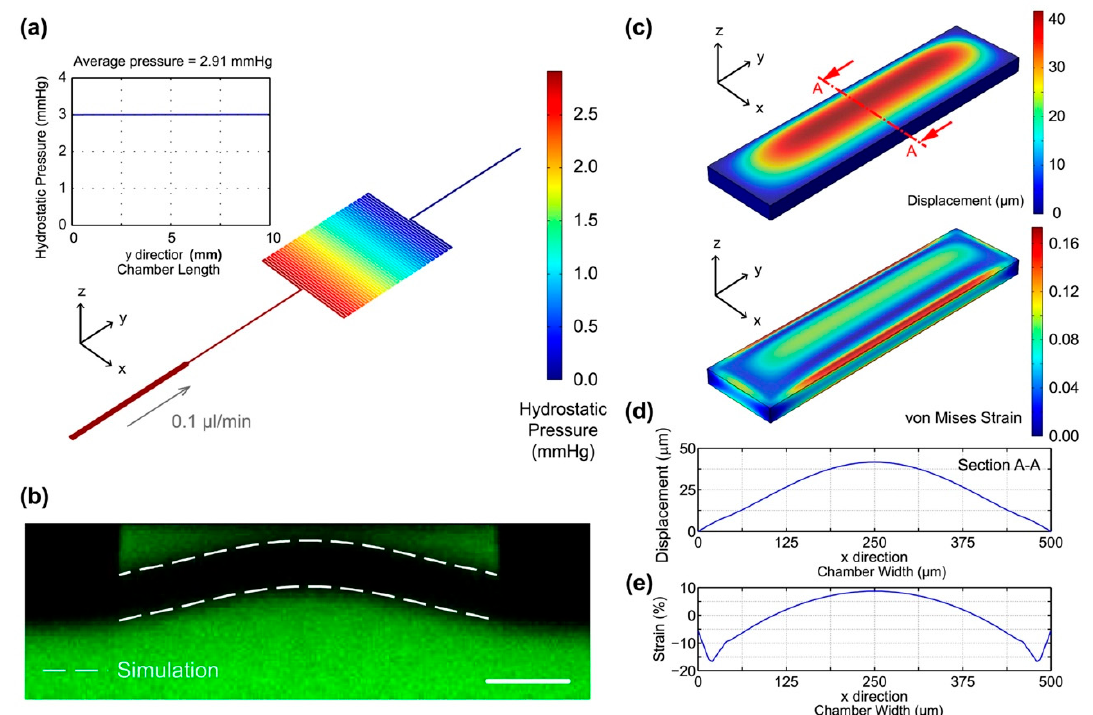
Figure 3. ( a ) The simulated hydrostatic pressure within the entire device. The inset demonstrates the uniform hydrostatic pressure along the flow direction in the cell culture chamber. ( b ) Confocal microscopic image showing the cross-section of the device with fluorescein solutions filled in the cell culture chamber and the actuation channel along the width of the cell culture chamber. The scale bar is 200 µ m. The simulated deformations of the membrane are plotted in dotted lines showing the good agreement between the simulated and experimental results. ( c ) Contour plots of the displacement and von Mises strain distributions of the entire membrane across the cell culture chamber. ( d ) Plots of the displacement and strain along the top surface of the membrane across the width of the cell culture chamber.